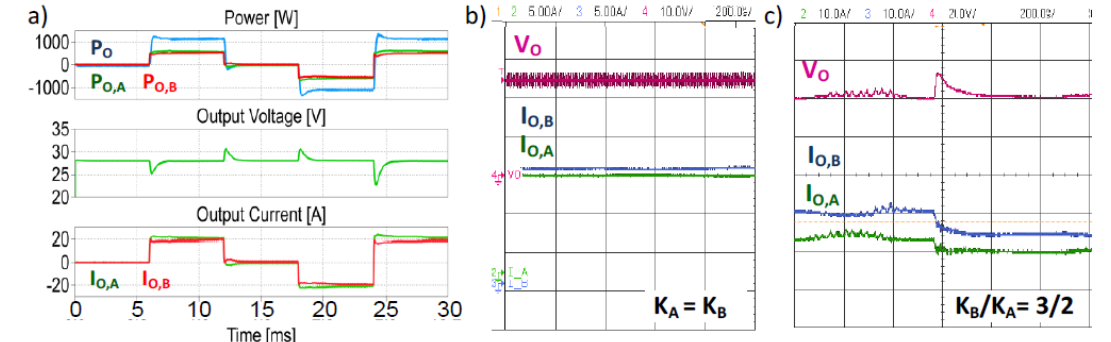
Figure 18. Parallel operation with droop control: converters working independently ( a ) and details of current unbalance between the two in the steady-state ( b ) and transient ( c ) regimes.